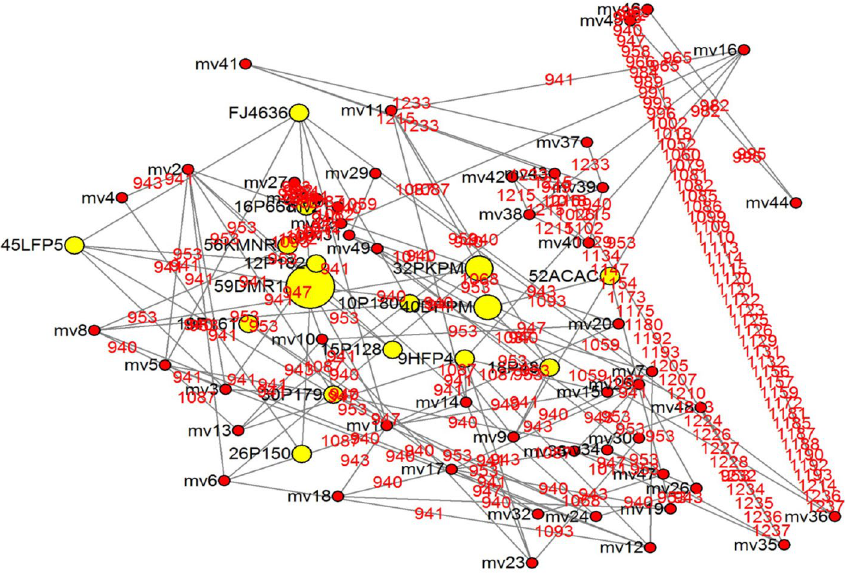
Figure 6. Median joining network with median vector (red color dots), mutated characters (red color taxa) and sequence frequency (yellow color